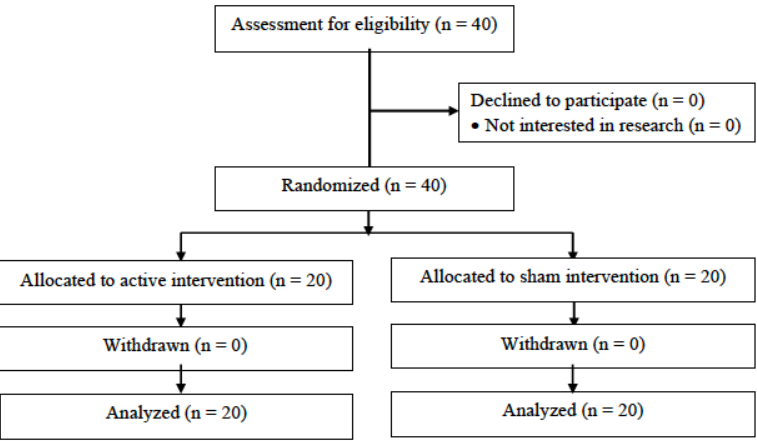
Figure 1. Study flow diagram. Table 1. Baseline Demographic and Clinical Characteristics of the Participants.